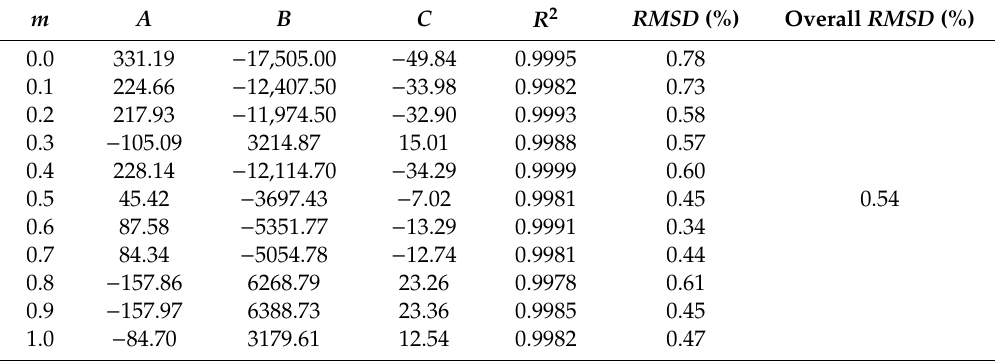
Table 4. Results of “Apelblat model” for PPN in “THP + water” combinations ( m ) c .